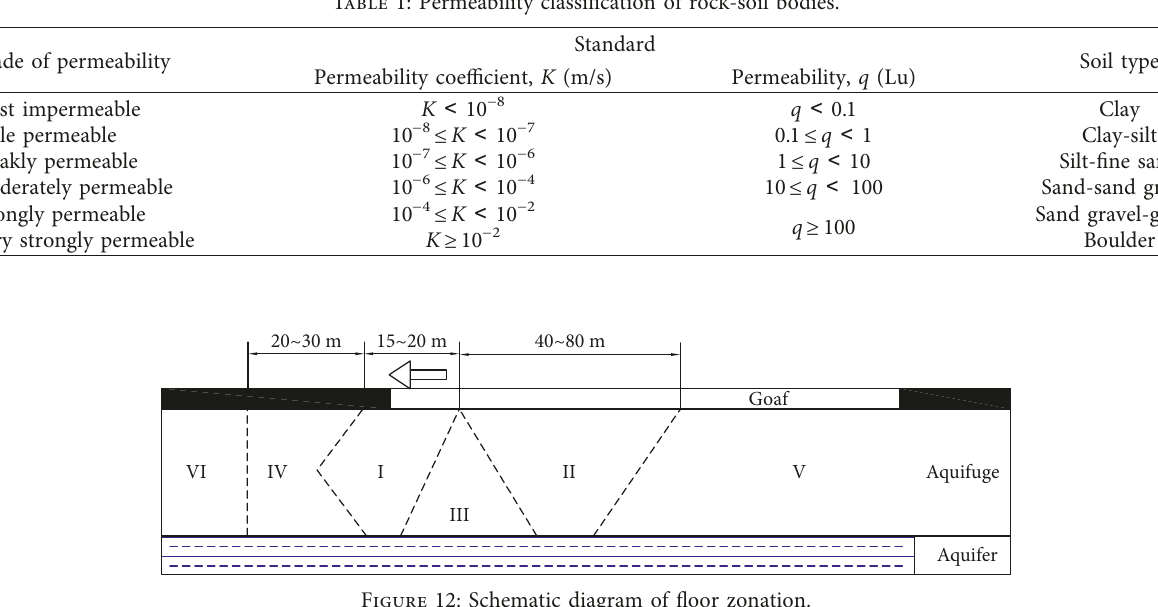
Figure 12: Schematic diagram of floor zonation.